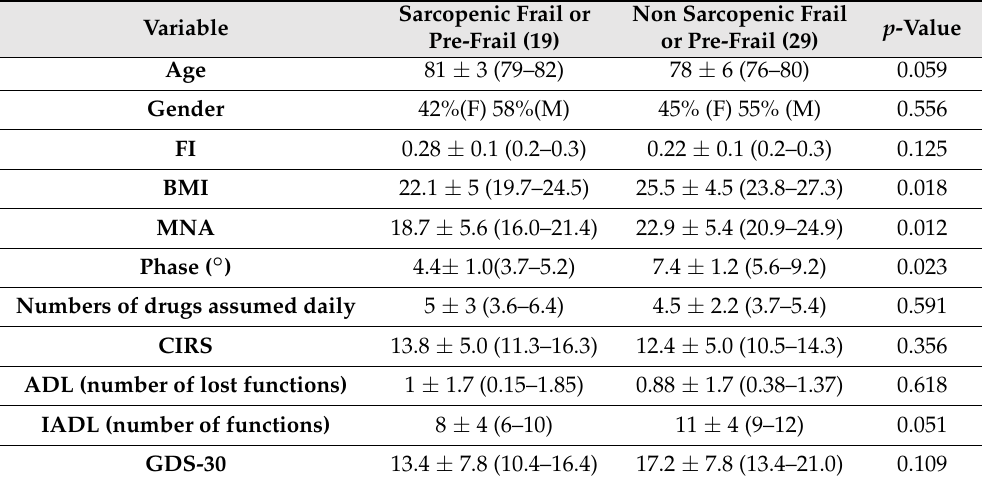
Table 4. Clinical characteristics of frail and pre-frail patients with or without sarcopenia . Mean and SD with CI are shown, and the p -values were calculated with one-way ANOVA. Sarcopenic Frail Variable